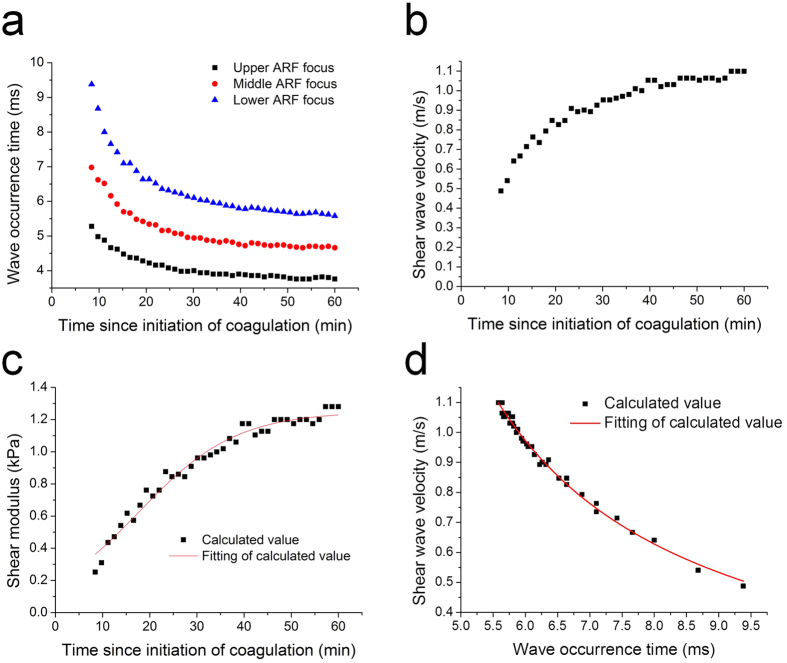
Analysis of the shear wave during blood coagulation.(a) The measured occurrence time of the shear wave at the wave detection point. Three ARF focus positions are applied for the measurement. (b) The calculated shear wave velocity during blood coagulation. The increase of the shear wave velocity indicates the blood clot becoming stiffer. (c) The shear modulus during blood coagulation. The shear modulus increases rapidly during the early stage of blood coagulation and becomes stable after 30 min. (d) Relation between the shear wave velocity and the shear wave occurrence time at the wave detection point with the lower ARF focus excitation.